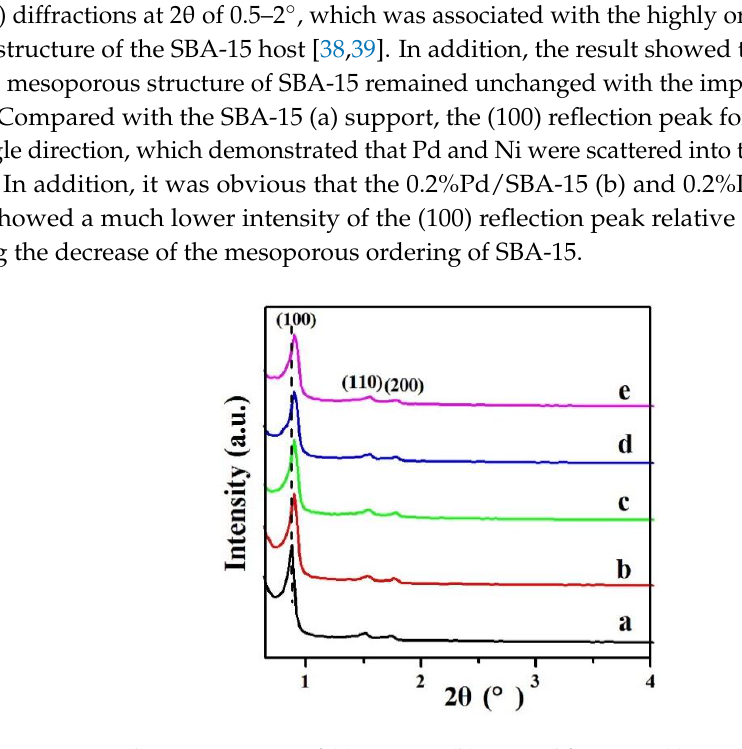
Figure 1. Low-angle XRD patterns of (a) SBA-15, (b) 0.2%Pd/SBA-15, (c) 0.2%Pd-0.4%Ni/SBA-15, (d) 0.2%Pd-0.7%Ni/SBA-15, (e) 0.2%Pd-1.2%Ni/SBA-15.